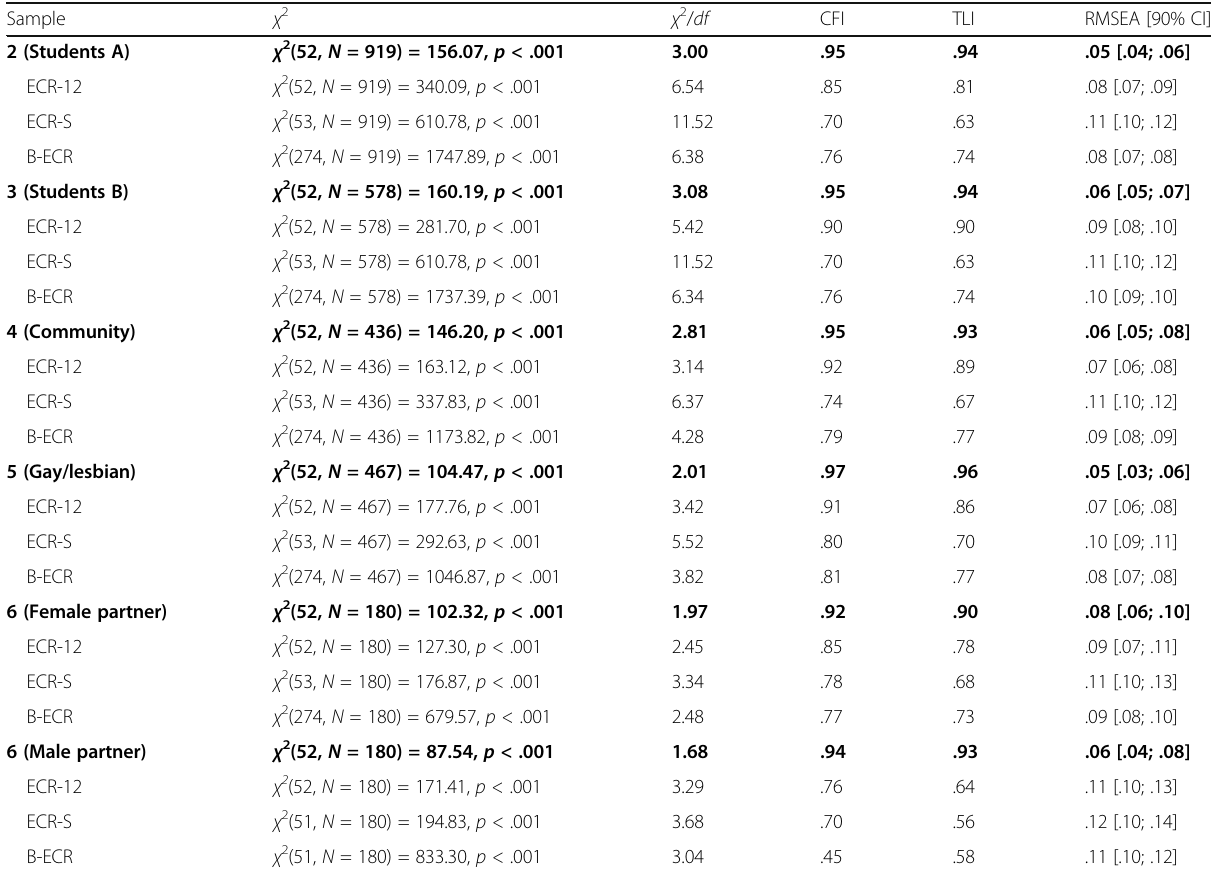
Table 3 Fit indexes for the confirmatory factor analyses of the Spanish ECR-12, French/English ECR-12, English ECR-S, and Chilean B-ECR